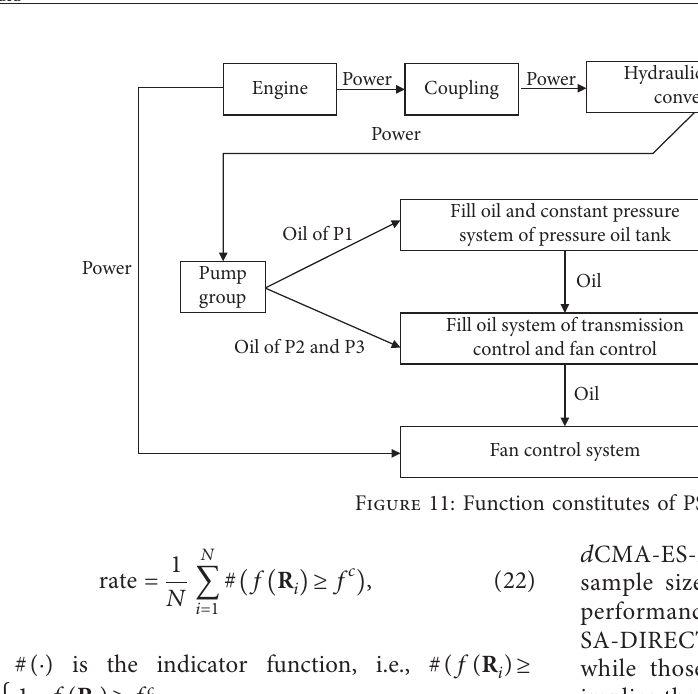
C R C s and s , denoted by s, bounded and s, bounded , respectively, based on the exact, GHZ, CES-IA, SA-DIRECT, and